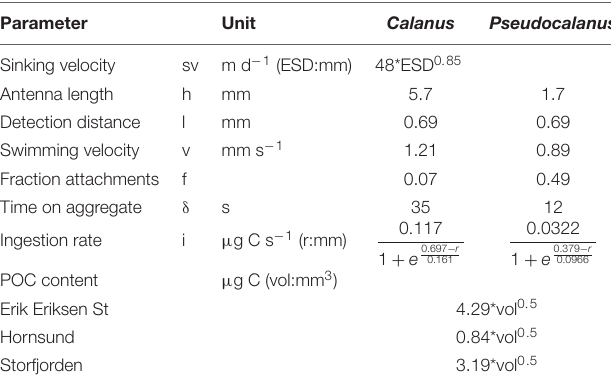
TABLE 4 | Parameters obtained from the experiments and in situ measurements used for calculating in situ aggregate